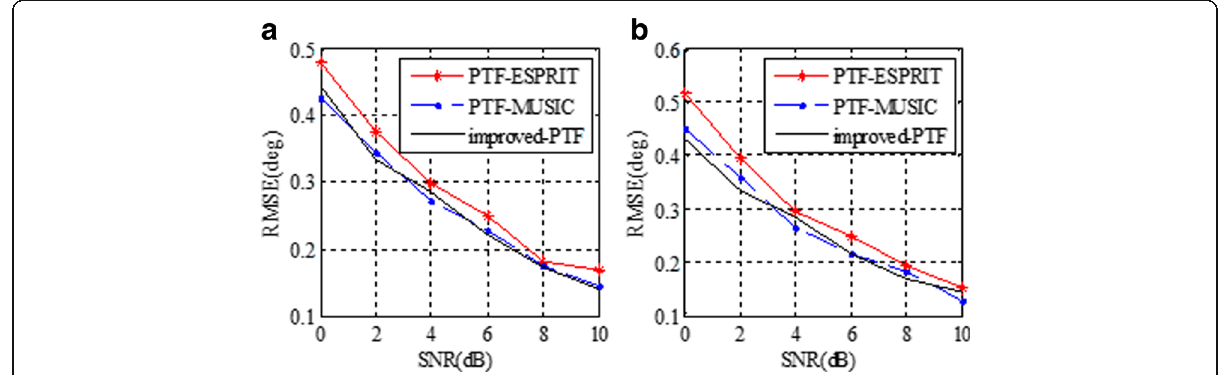
Fig. 7 RMSE of two signals: a RMSE of signal 1. b RMSE of signal